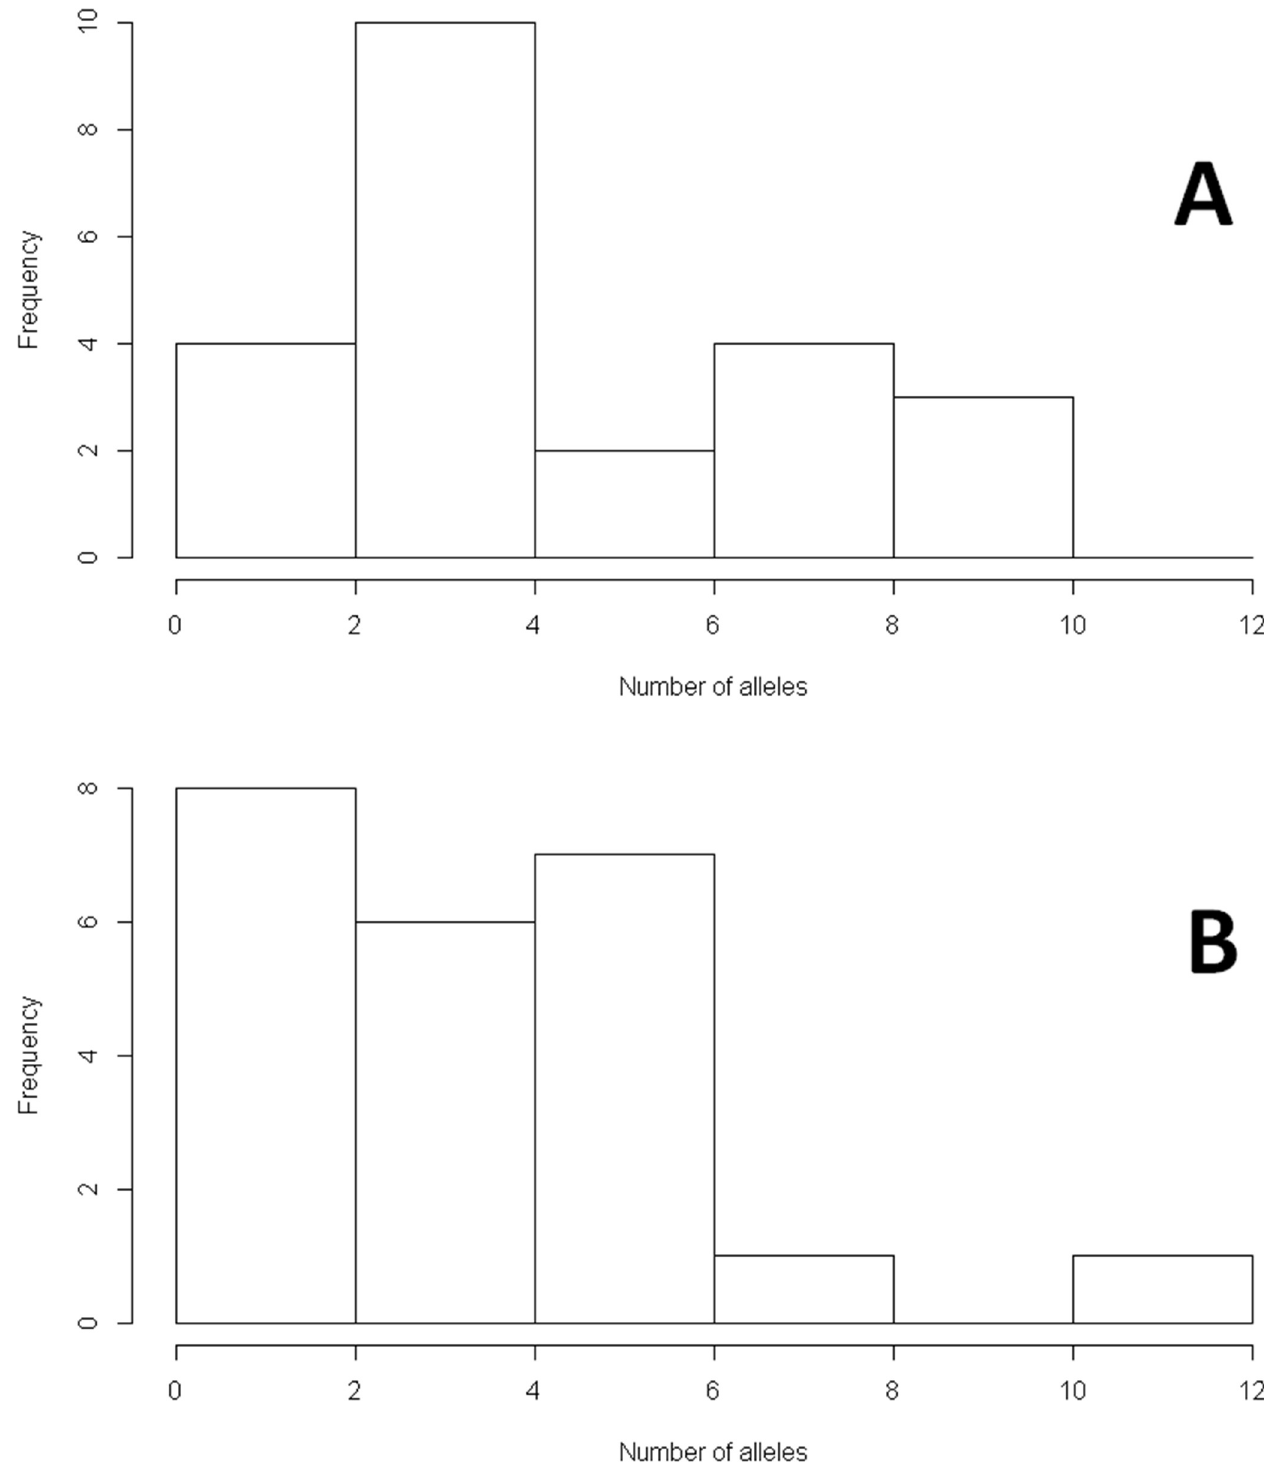
Fig 2. Number of alleles per locus in two Pinus albicaulis populations. Histograms of the count frequency per locus for number of alleles for all of 23 microsatellite loci for two populations of Pinus albicaulis Engelm. (Pinaceae) A) Henderson Mountain, Custer Gallatin National Forest, MT, and B) Mount Washburn, Yellowstone National Park,